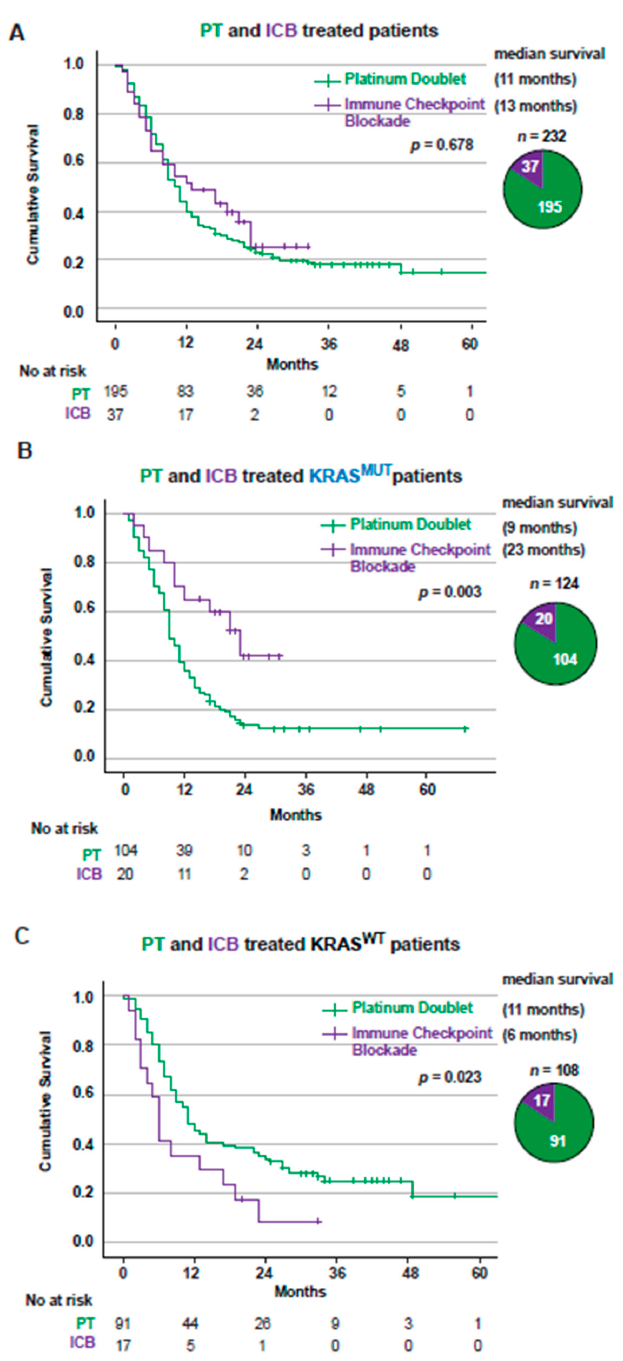
Figure 3. KRAS MUT , but not KRAS WT , had a better outcome with ICB than with platinum doublet treatment. ( A ) Kaplan–Meier estimates comparing overall survival for all patients, excluding pa- tients with ALK or EGFR alterations, receiving treatment with PT vs. ICB. Pie chart showing patient distribution between PT and ICB. ( B ) Kaplan–Meier estimates comparing overall survival for all KRAS MUT receiving treatment with PT vs. ICB. Pie chart showing patient distribution between plat- inum doublet and ICB. ( C ) Kaplan–Meier estimates comparing overall survival for KRAS WT , exclud- ing patients with ALK or EGFR alterations, receiving treatment with platinum doublet vs. ICB. Pie chart showing patient distribution between PT and ICB. ICB: Immune checkpoint blockade; PT: Platinum doublet. 3.4. PD-L1 Expression in Tumors from Stage IV Patients Is a Positive Factor for Overall Sur- vival in KRAS MUT but Not KRAS WT Patients Currently, tumoral PD-L1 expression is the only biomarker for ICB treatment widely used in the clinic for NSCLC [41,42]. When analyzing all treated Stage IV NSCLC patients with known PD-L1 status ( n = 261) stratified on KRAS mutational status and PD-L1 ex- pression levels (negative, low or high) (Figure 4A), we observed that increased PD-L1 ex- pression correlated with significantly better OS in KRAS MUT patients ( p = 0.036, Figure 4B). KRAS MUT patients were clearly separated on OS between PD-L1 negative, low and high groups with median OS of 6, 11 and 17 months, respectively (Figure 4B). In multivariate Cox regression analysis, PD-L1 was an independent positive factor, and ECOG 2 or higher